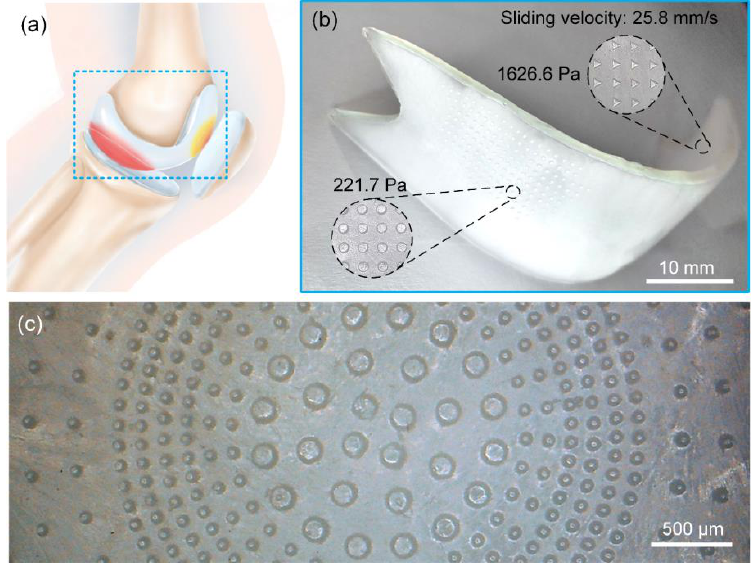
Figure 10. Rational selective design and application of hydrogel surface micro-pits. ( a ) Frictional- wear differences in knee cartilage. ( b ) A double-sided heterogeneous hydrogel. ( c ) A one-sided hydrogel with different sizes of circular micro-pits.